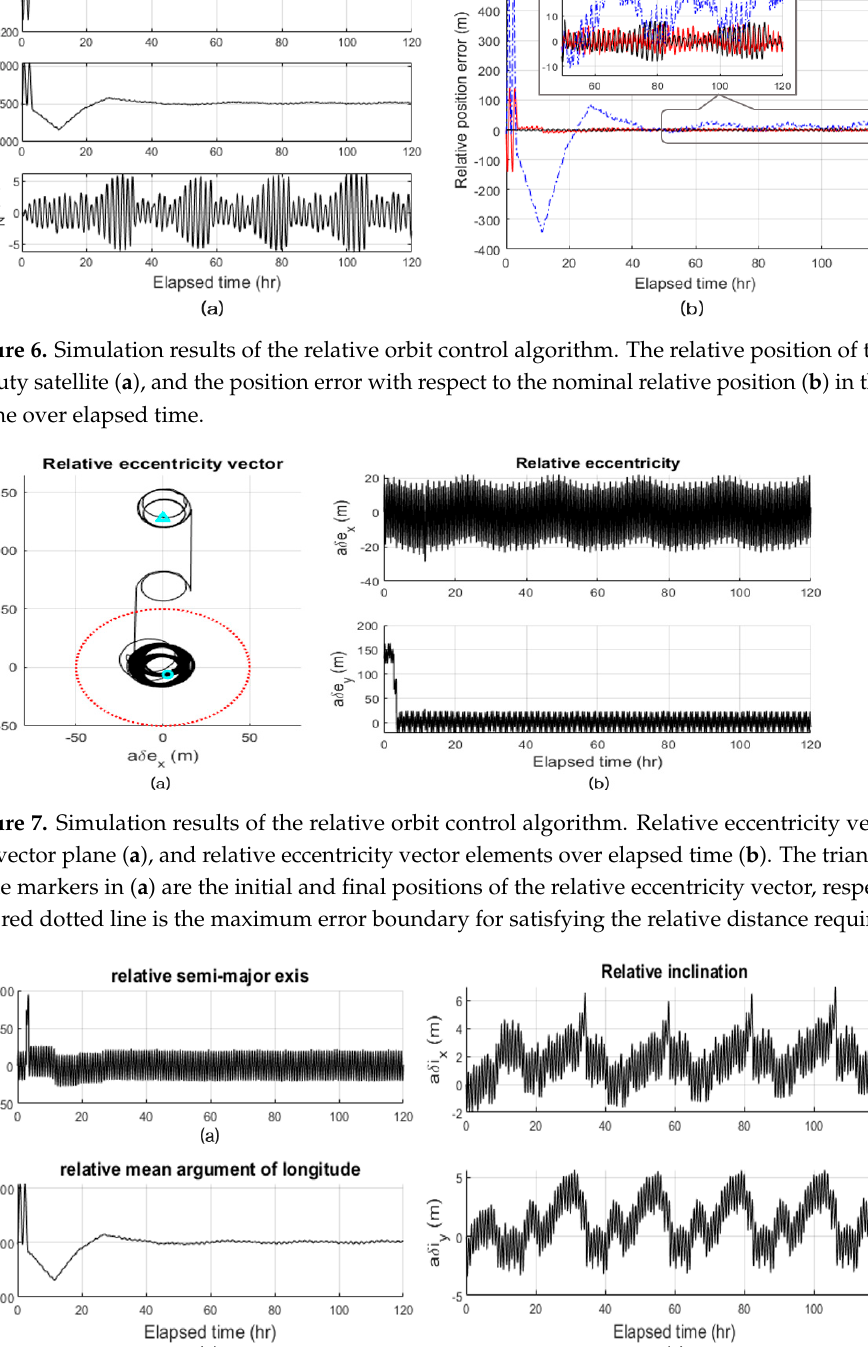
Figure 7. Simulation results of the relative orbit control algorithm. Relative eccentricity vector on the vector plane ( a ), and relative eccentricity vector elements over elapsed time ( b ). The triangle and circle markers in ( a ) are the initial and final positions of the relative eccentricity vector, respectively. The red dotted line is the maximum error boundary for satisfying the relative distance requirement.